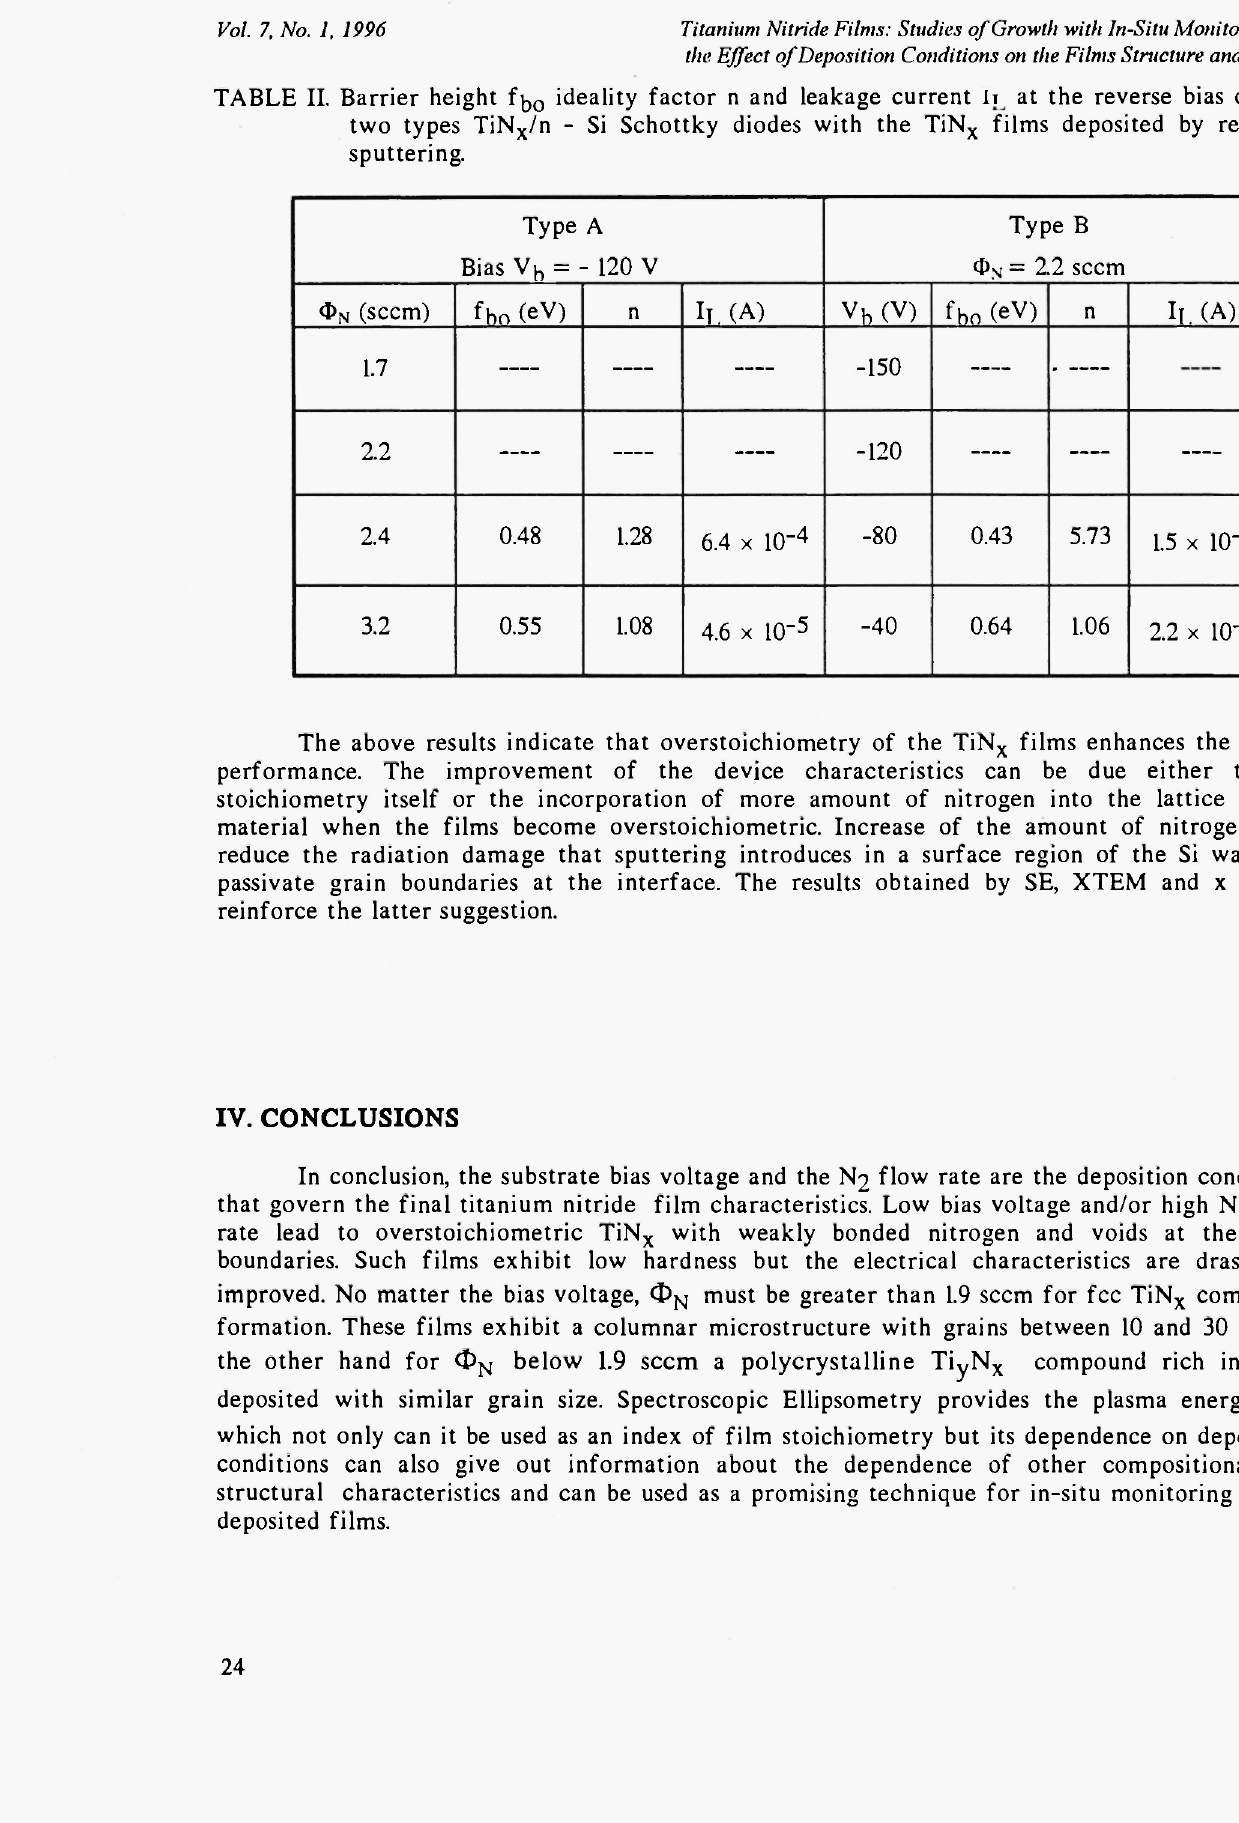
TABLE II. Barrier height fjj 0 ideality factor η and leakage current at the reverse bias of 1 V two types TiN x